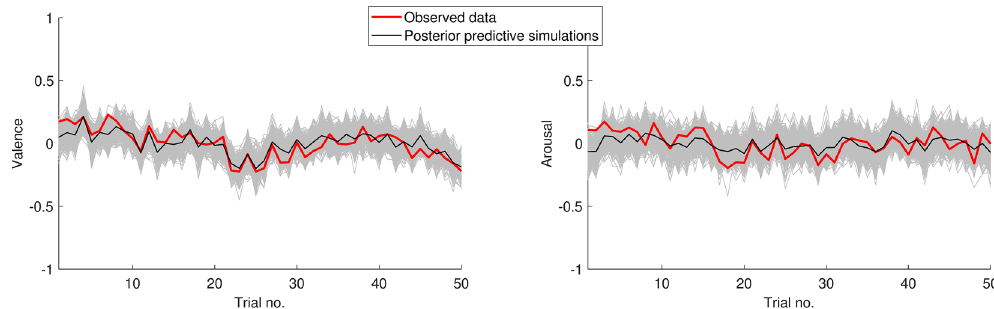
Figure 2. Posterior predictive checks for the affect model. Average valence and arousal over the experiment are shown (solid red) together with 500 posterior predictive simulations from the affective experience model (grey area) and the median predictions (solid